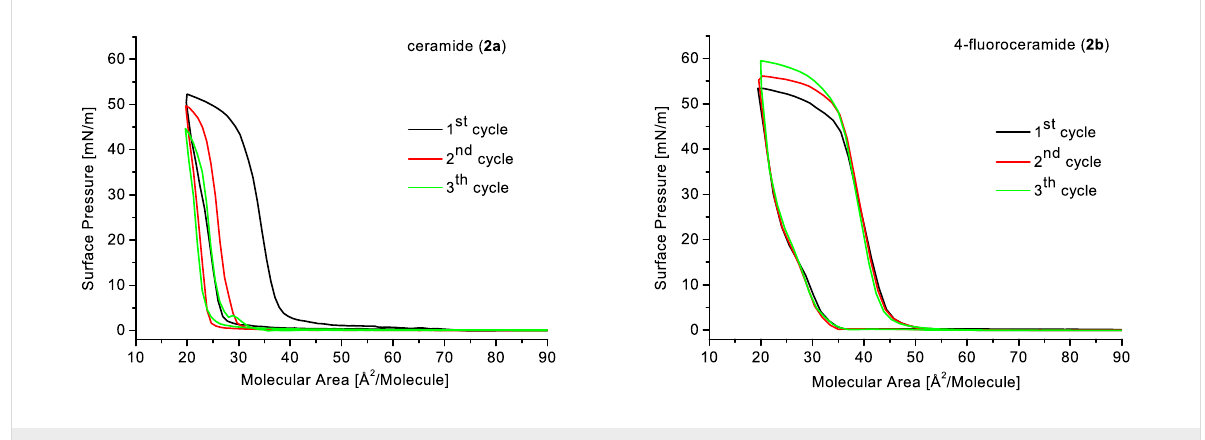
Figure 4: Cycles of compression and expansion for ceramide ( 2a ) and 4-fluoroceramide ( 2b ).